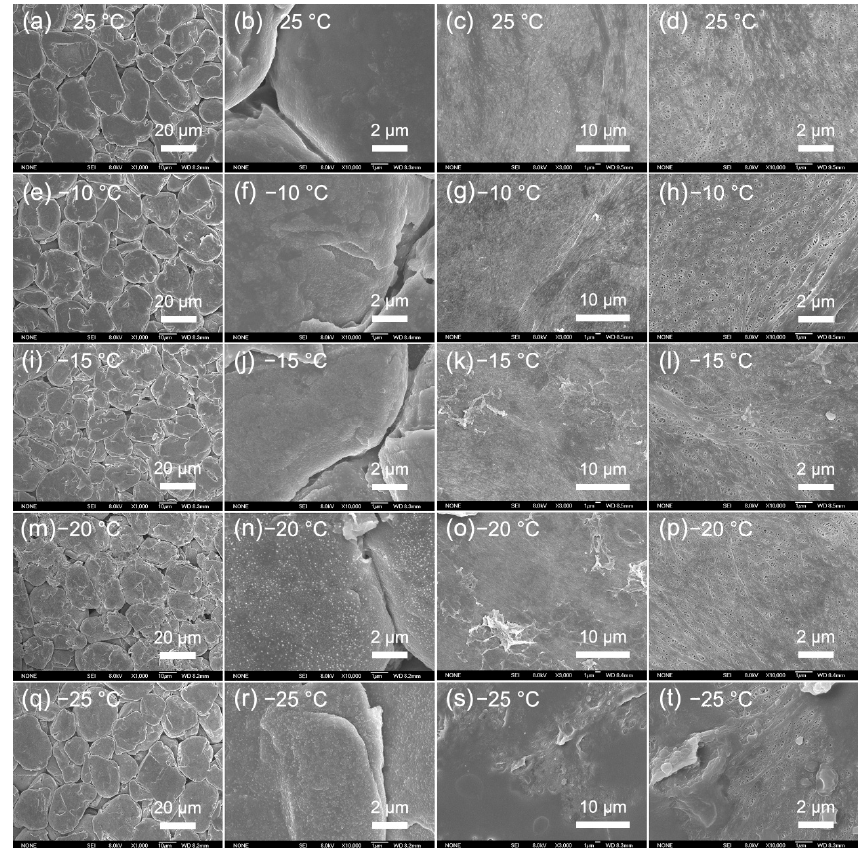
Figure 9. Field emission scanning electron microscopy (FESEM) images of the anode surfaces (left side) and separator surfaces (right side) dismantled from the 18650 lithium-ion battery cells after charging at 1 C, and the environmental temperatures were set to ( a – d ) 25 °C, ( e – h ) − 10 °C, ( i – l ) − 15 °C, ( m – p ) − 20 °C and ( q – t ) − 25 °C.